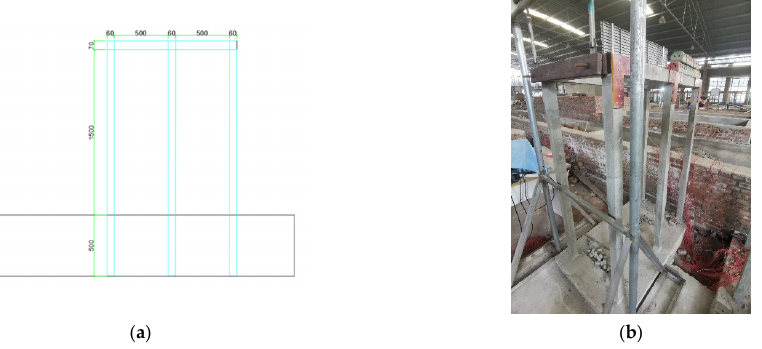
Figure 9. Dynamic response test model of wharf frame structure. Attachment: Dimension in cm ( a ) Longitudinal section of the model. ( b ) Dynamic response test model of wharf frame. As a control of damage identification, a wharf frame model with damage was made under the same conditions. Then, crack damage was set at the joint position of the model pile and beam, and the damage degree was 40%. This was compared with the transient acceleration response of the complete structure. The test model with damage is shown in Figure 10.